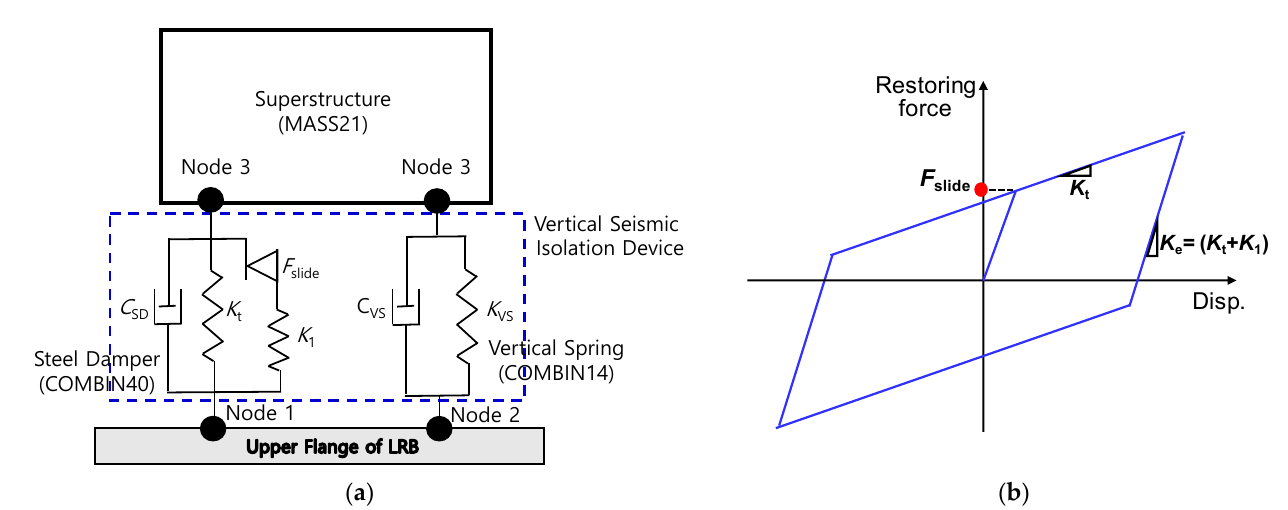
Figure 3. Used vertical seismic input motion (PGA = 0.5 g): ( a ) Floor response spectrum; ( b ) acceler- ation time history; ( c ) displacement time history.